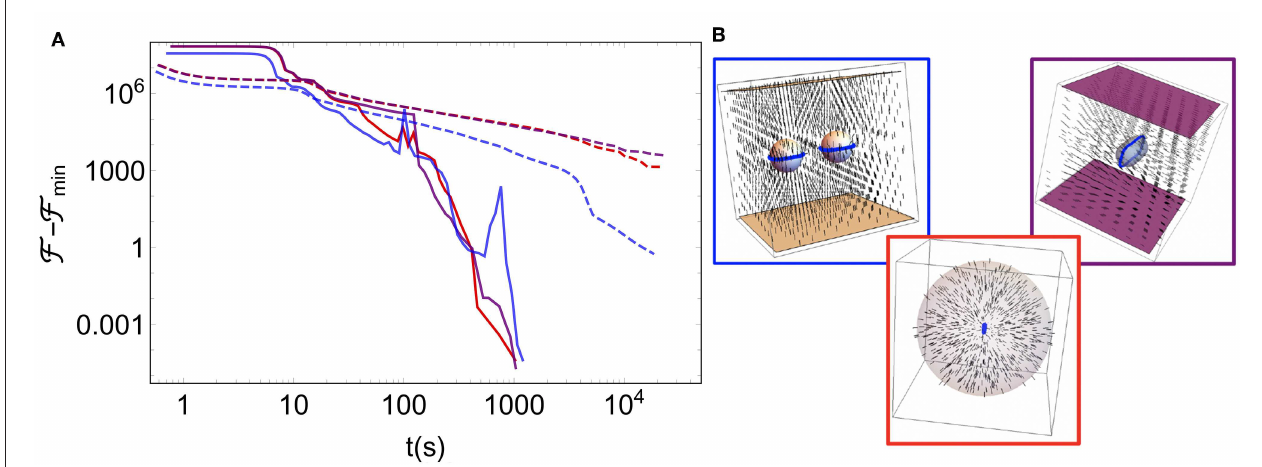
FIGURE 3 | (A) Energy relative to the minimized energy for three different geometries as a function of wall-clock time, in a lattice of size N randomly initialized configuration. As in Figure 2 , solid lines are minimizations using FIRE and dashed lines are those using gradient descent. As depicted in (B) showing the minimized configurations, the three sets of lines correspond to (Blue) two spherical colloids between parallel plates, all with homeotropic anchoring, (Red) the interior of a spherical droplet with homeotropic anchoring, and (Purple) a spherocylinder with homeotropic anchoring between parallel plates with degenerate planar anchoring. These images were created using the “multirankImages.nb” Mathematica file included in the repository for making simple visualizations.